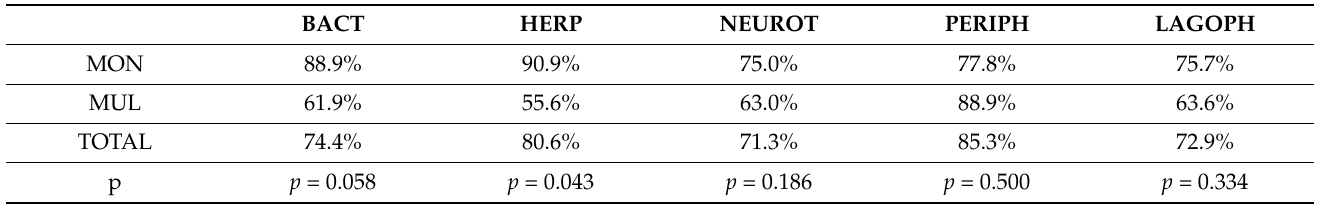
Table 3. Relationship between the number of AM layers and success rate according to ulcer etiology. BACT HERP